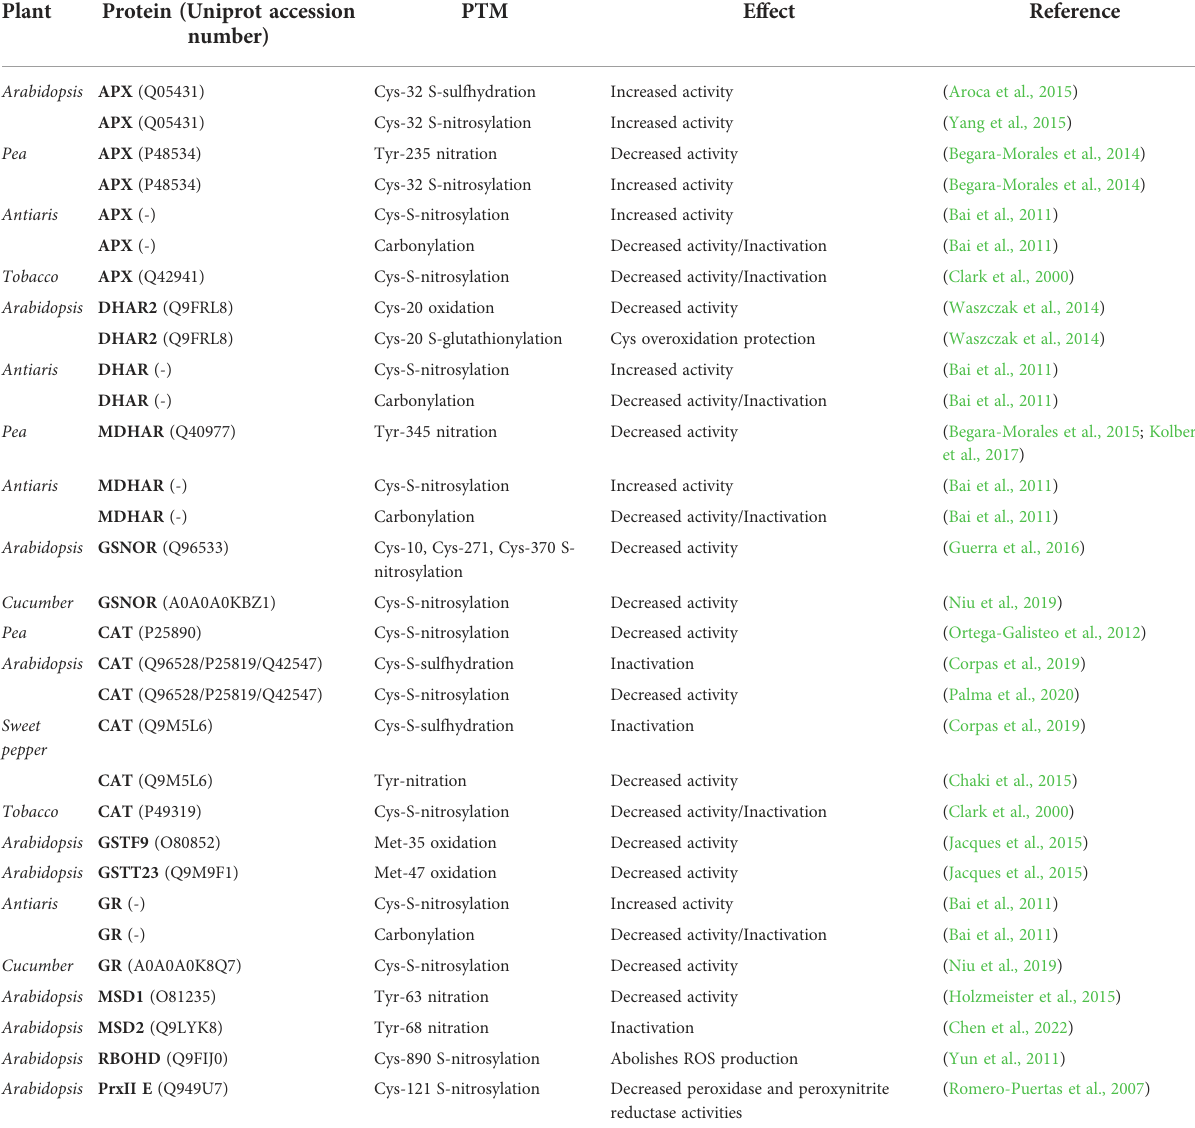
TABLE 1 PTMs and their effect on the different oxidative metabolism-related proteins subjected to redox regulation.